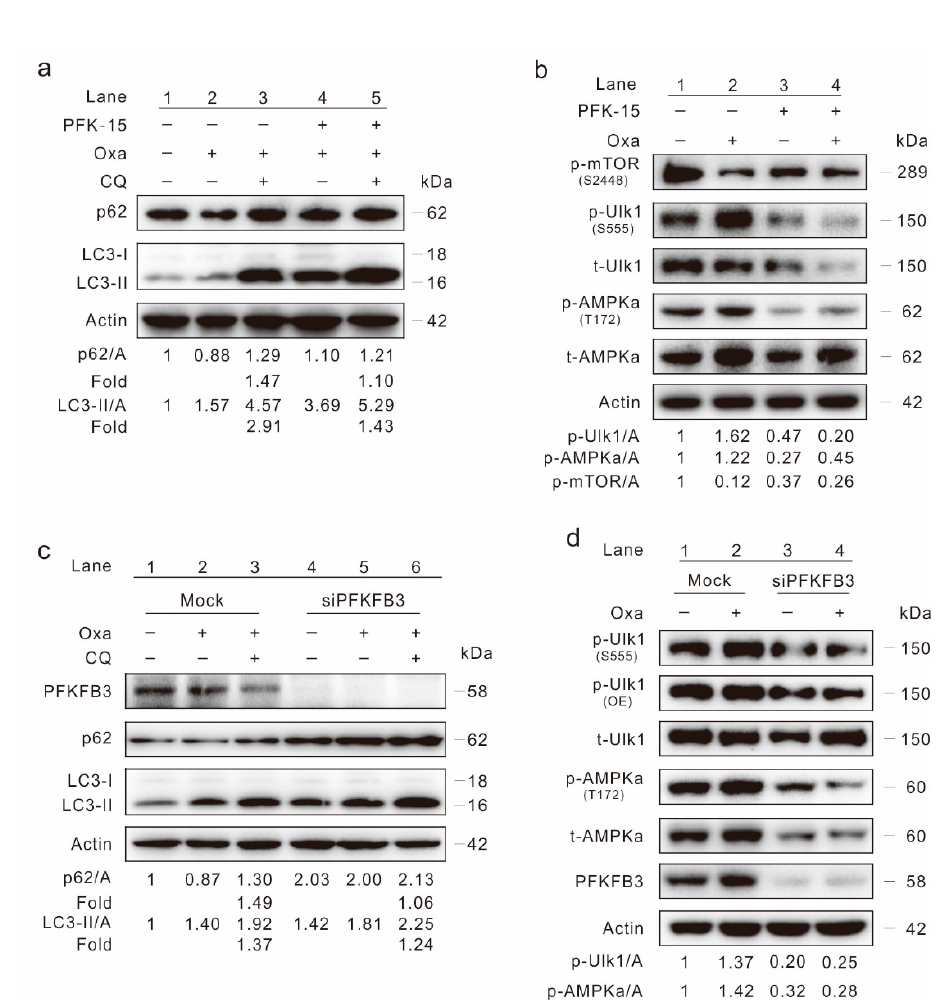
Figure 4. PFKFB3 inhibition lessens Oxa-induced autophagy. ( a , b ) Cell lysates were subjected to immunoblotting following treatment of SW480 cells with Oxa, or together with PFK-15 (6 µ M; unless otherwise indicated) in the presence or absence of CQ for 2 h. ( c , d ) SW480 cells were transfected with the PFKFB3 siRNA or control siRNA (mock) for 48 h. Cell lysates were collected and subjected to immunoblotting following treatment with Oxa in the presence or absence of CQ for 2 h. All data were acquired from at least three independent experiments.